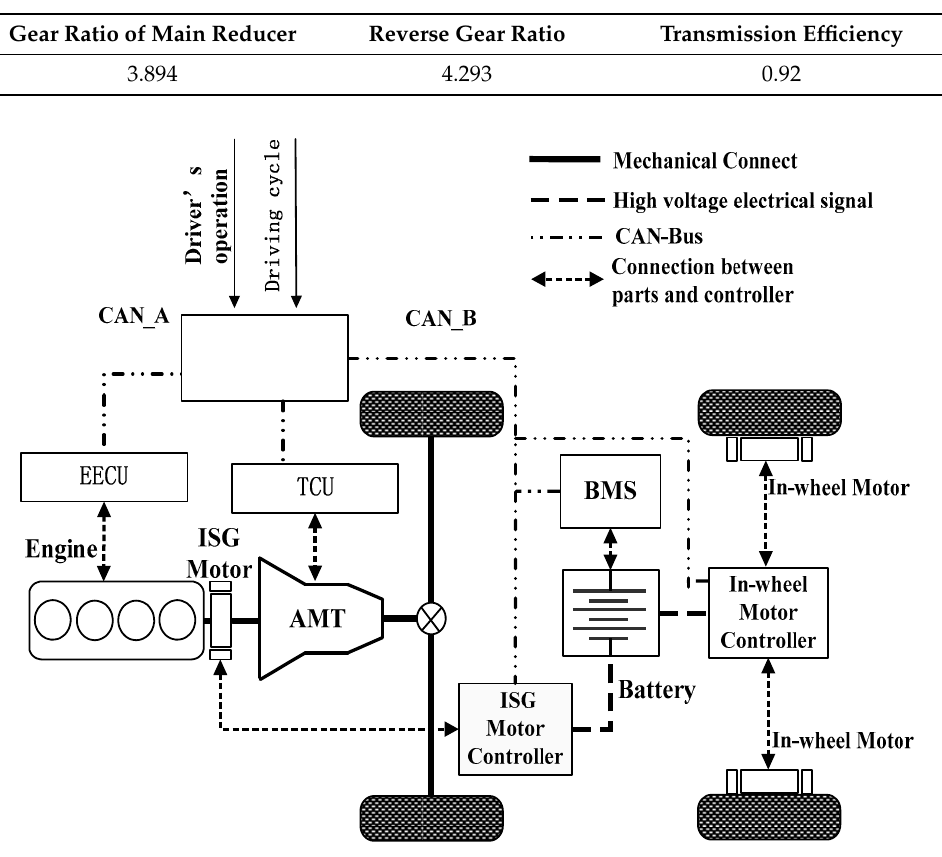
Table 7. Transmission parameters of four-wheel drive HEV.